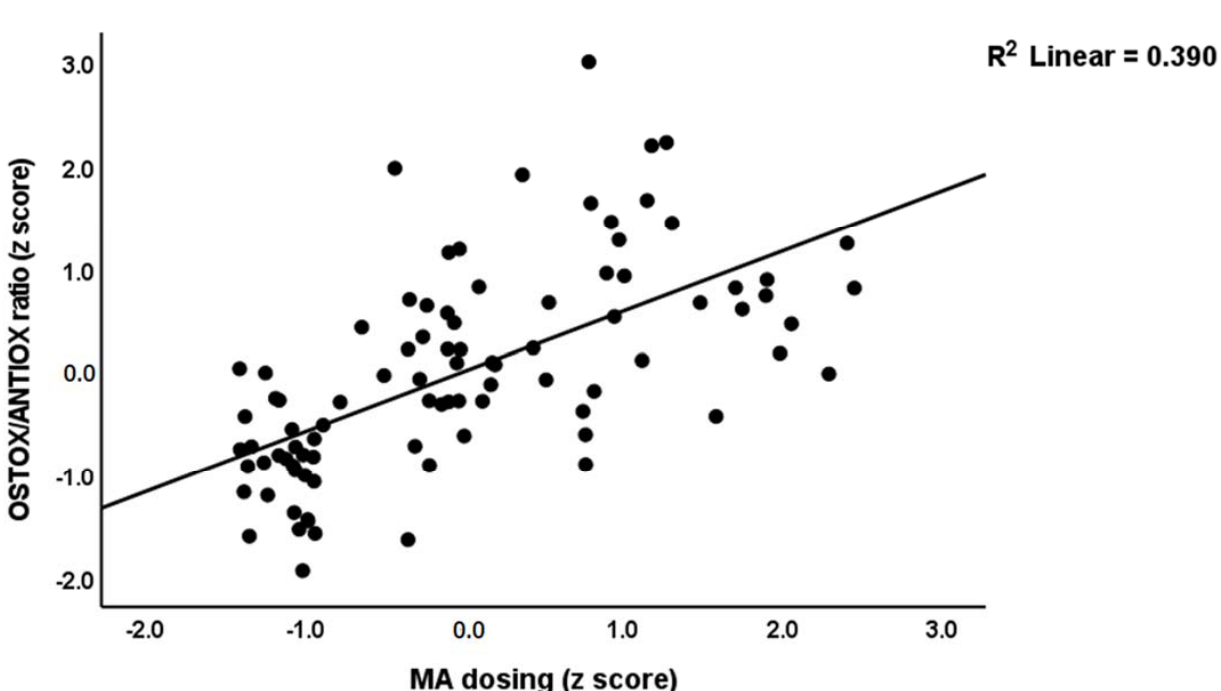
Figure 5. Partial regression plot of the oxidative toxicity/antioxidant defenses (OSTOX/ANTIOX) ratio on methamphetamine (MA) dosing.